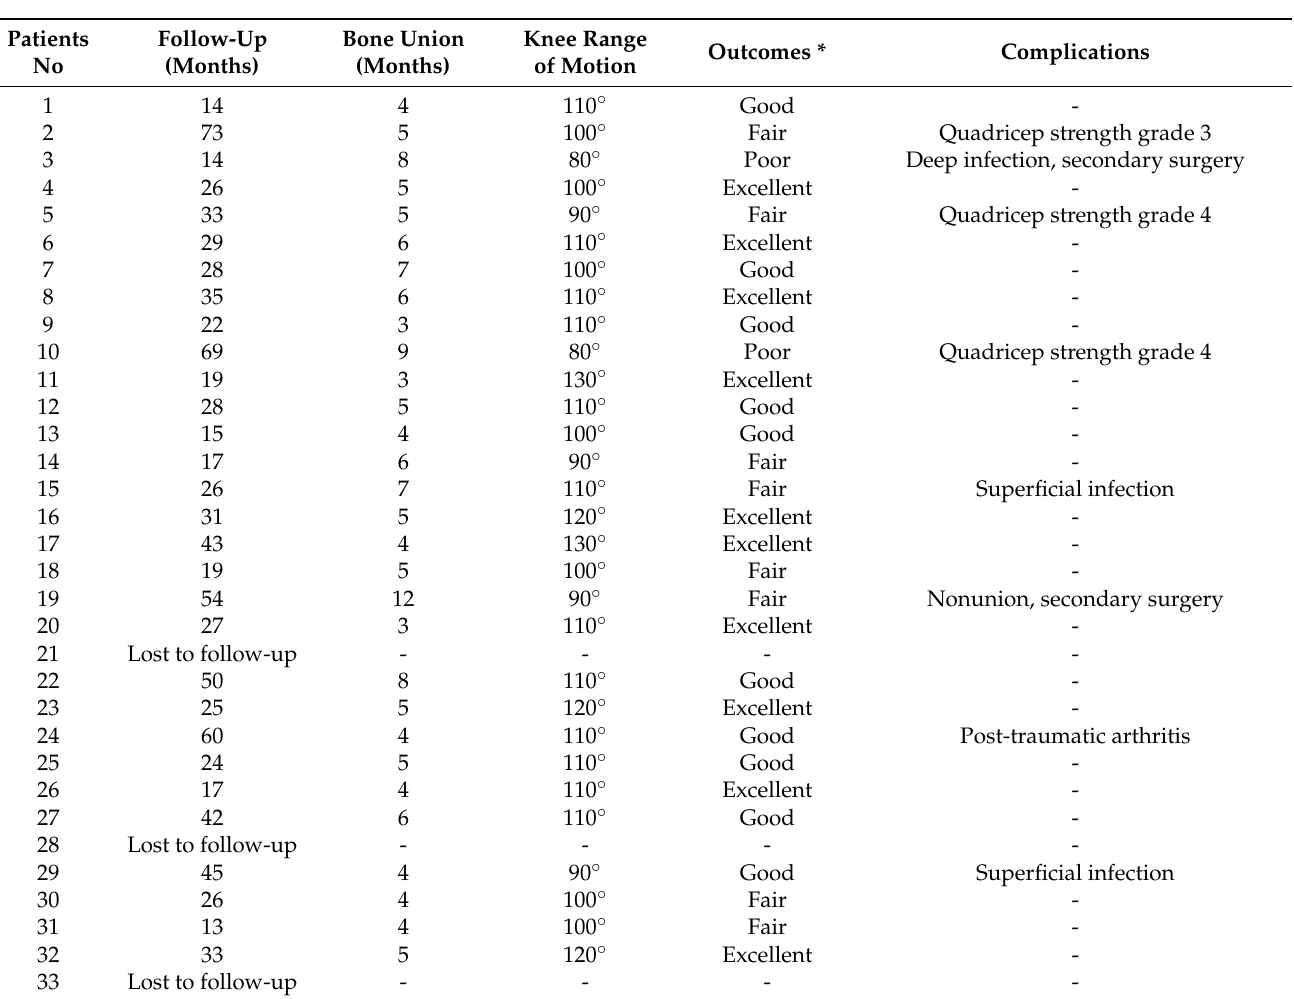
Table 2. Outcomes of the